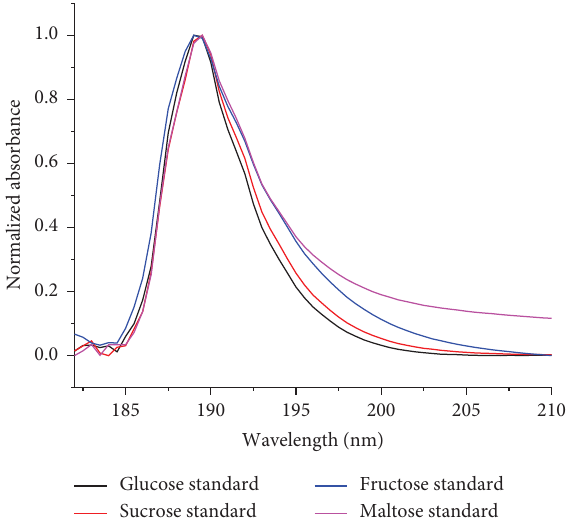
Figure 5: Normalized absorption spectra of the four sugar stan- dards dissolved in